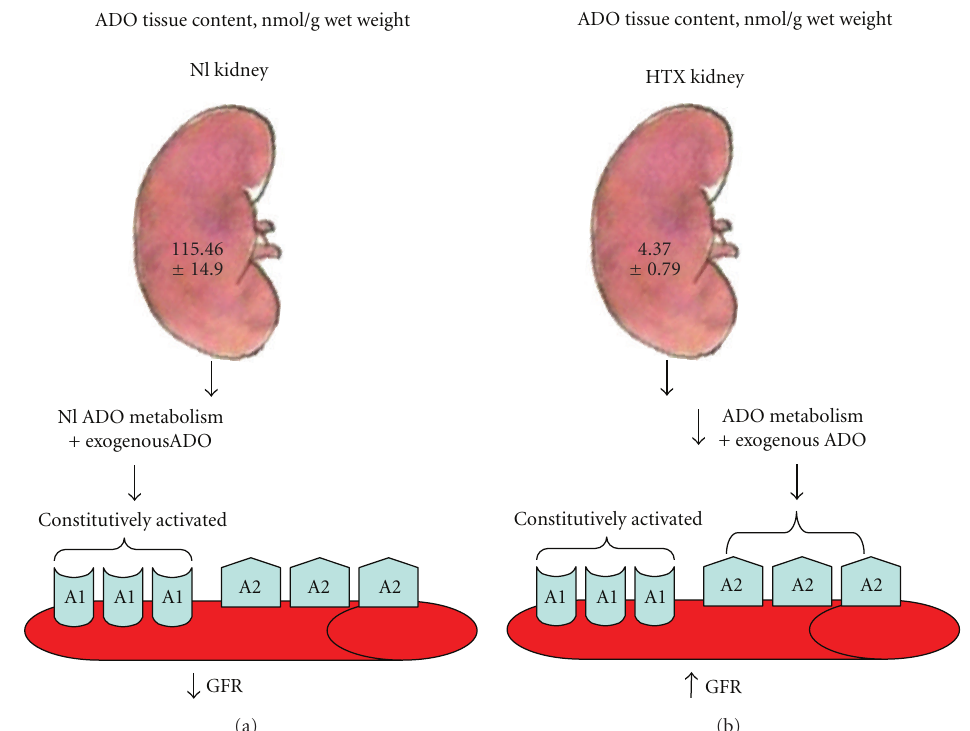
Figure 5: The adenosine tissue content is markedly a ff ected by hypothyroidism; under normal conditions, the metabolism of adenosine is very fast, thus the administration of exogenous adenosine within the μ molar range activates preferentially the high-a ffi nity A1 receptors and induces vasoconstriction (a). In contrast, under hypothyroid conditions, since the metabolism of adenosine is abnormally low, exogenous adenosine reaches concentrations high enough to activate adenosine A2 receptors and induce vasodilation,